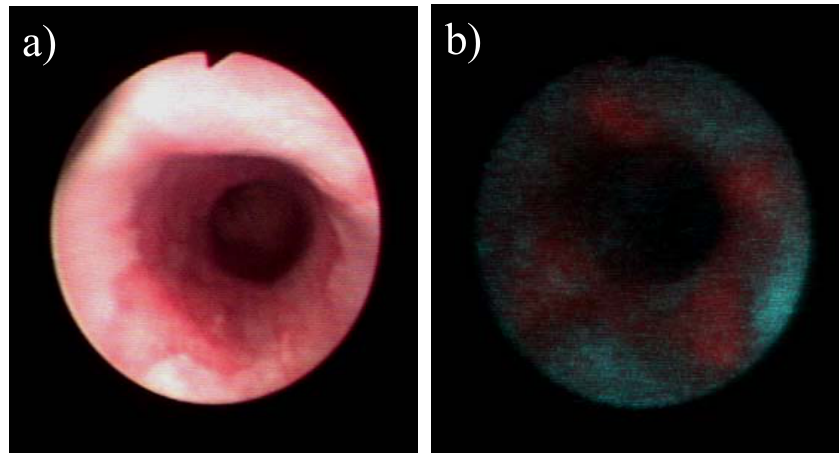
FIGURE 5 . In vivo example of (a) WLE image of Barrett’s esophagus and (b) corresponding fluorescence image showing red ALA-induced PpIX fluorescence selectively localizing on Barrett’s mucosa relative to normal squamous mucosa, which appears cyan colored (ALA dose 2 mg/kg, image taken at 1 h postadministration).